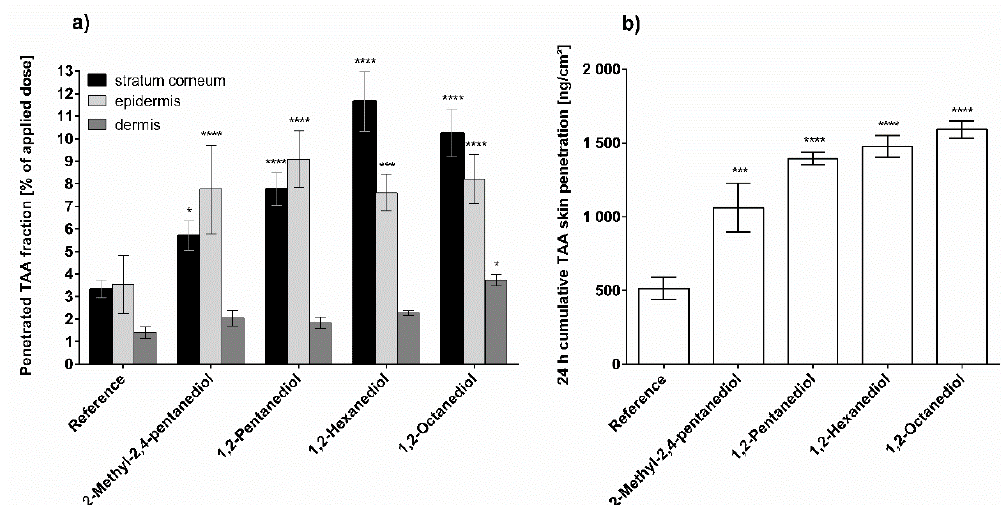
Figure 2. Triamcinolone acetonide penetration from pure aqueous carbomer gel (reference) and aqueous carbomer gel with 5% alkanediol after 24 h incubation; ( a ) Penetrated fraction in stratum corneum, viable epidermis and dermis; ( b ) Cumulative skin penetration of triamcinolone acetonide, n = 3, mean ± SD, * p ≤ 0.05; *** p ≤ 0.001; **** p ≤ 0.0001.